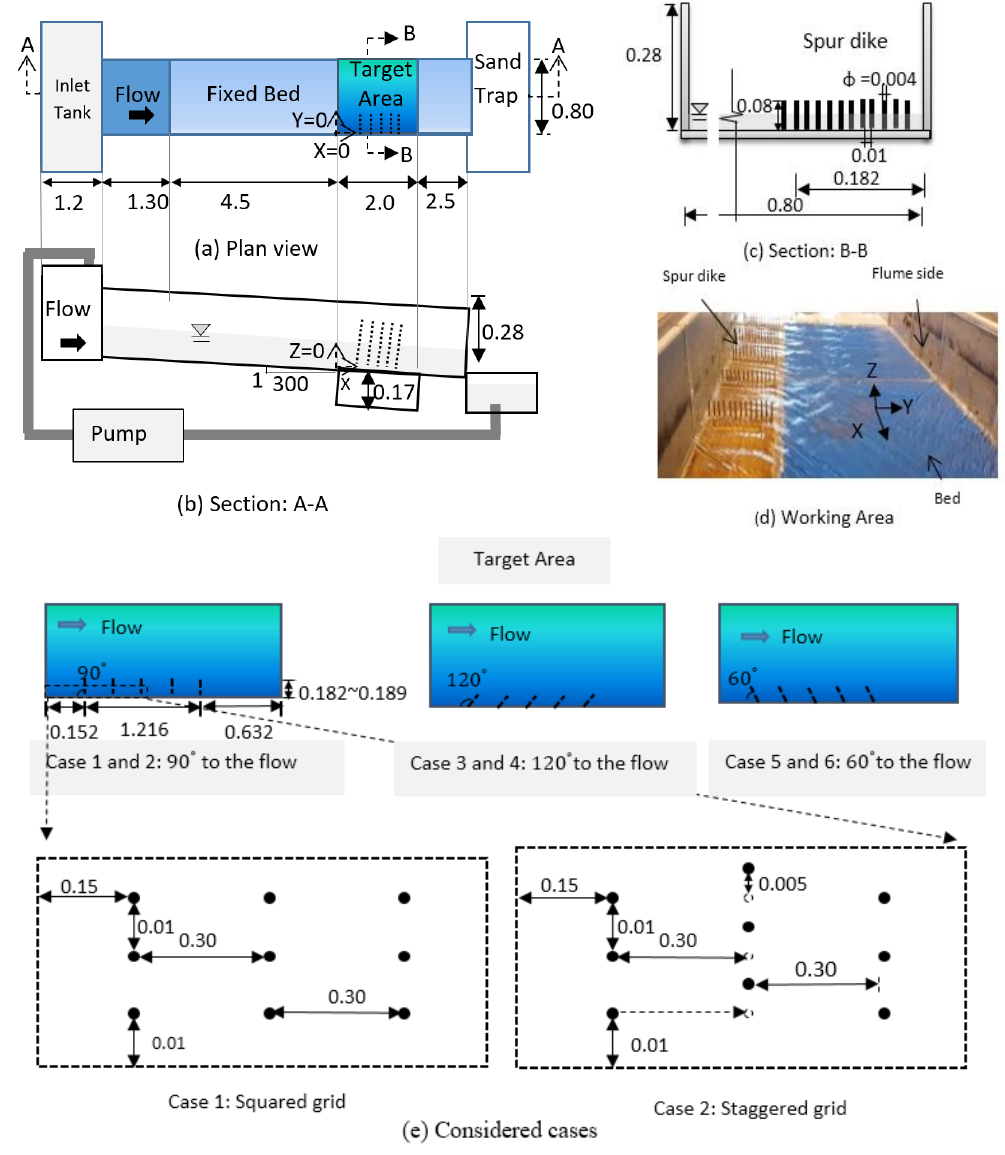
Figure 3. Experimental configuration (unit: m). Table 1. Experimental case details. Table 2. Experimental